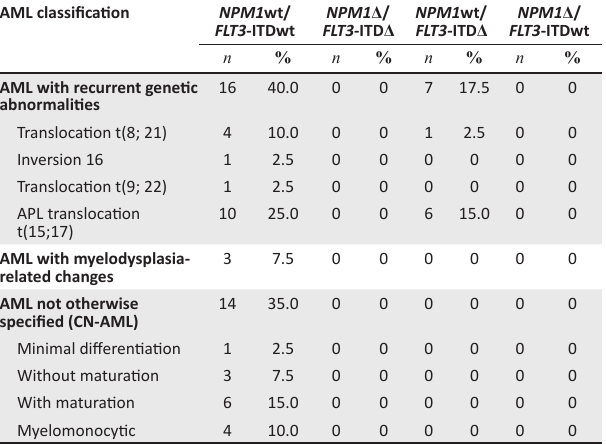
Table 1 : Classification of acute myeloid leukaemia patients’ NPM1 and FLT3 -ITD genotypes (August 2020, Bloemfontein, Free State, South